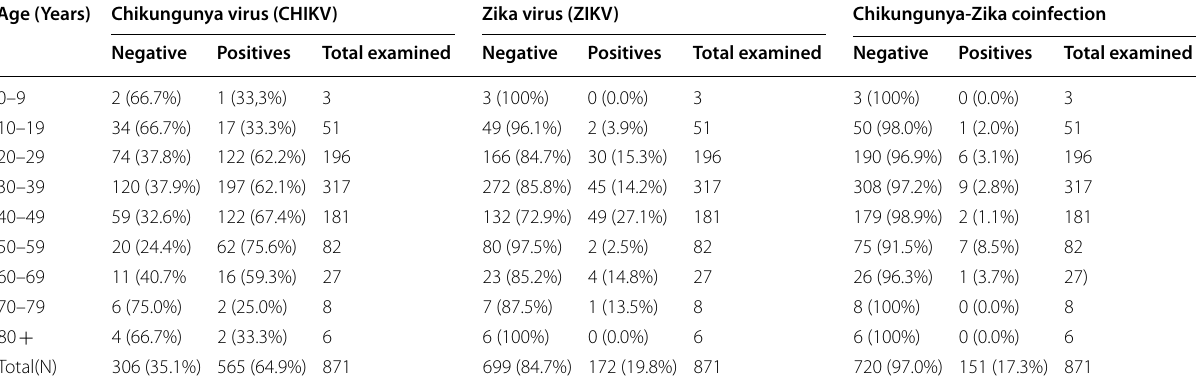
Table 3 Age specific seroprevalence of chikungunya, Zika and chikungunya-Zika cocirculation Age (Years) Chikungunya virus (CHIKV) Zika virus (ZIKV) Chikungunya-Zika